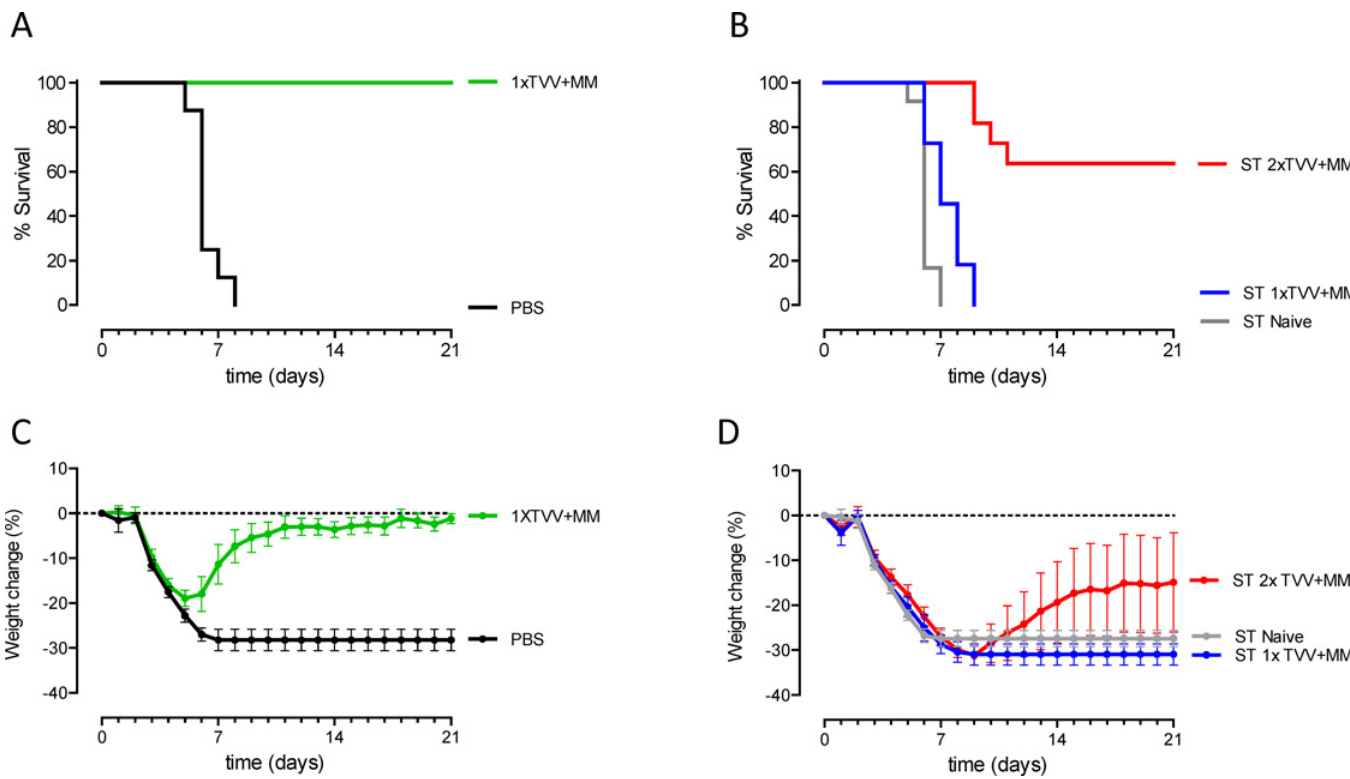
Fig 1. Serum antibodies confer partial protection against H5N1. (A) Mice (n = 8/group) were immunized once with TVV+MM or PBS as negative control 4 weeks before challenge. (B) Recipient mice (n = 11-12/group) received 400 μ l immune sera of 1-time or 2-times TVV+MM immunized donors or na ï ve serum intraperitoneally one day before challenge. Mice were challenged with 12.5xLD 50 of wild type H5N1 A/Hong Kong/156/97 and monitored for 21 days for survival and weight-loss. Graphs A and B represent the Kaplan-Meier survival curves and graphs C and D represent mean bodyweight change with 95% confidence interval. ST = serum